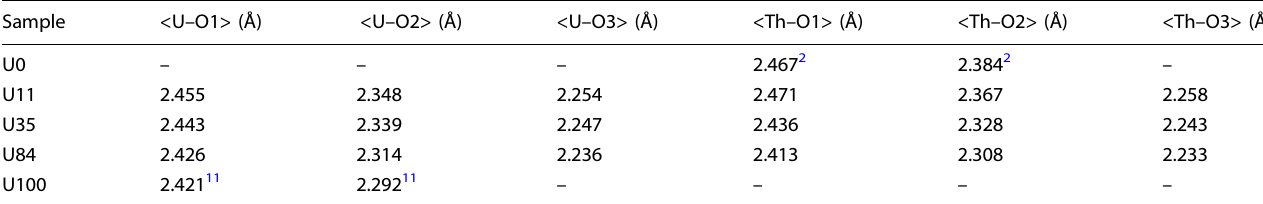
Table 2. RMC-re fi ned bond lengths of <U – O> and <Th – O> in uranothorite with varying U and Th contents.